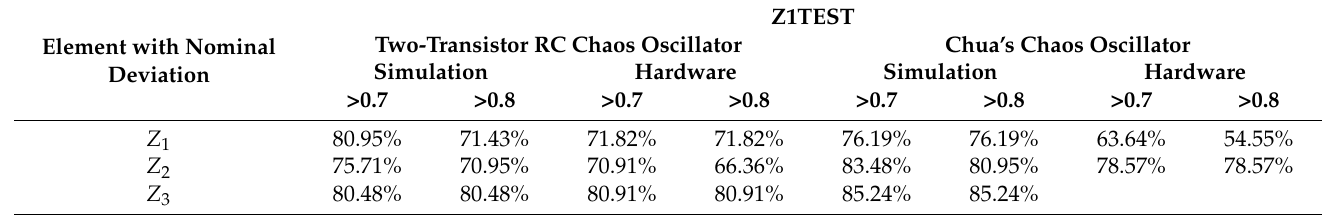
Table 1. Simulation and hardware experimental results of RC and Chua’s chaos oscillator dynamic estimation in the master circuit.